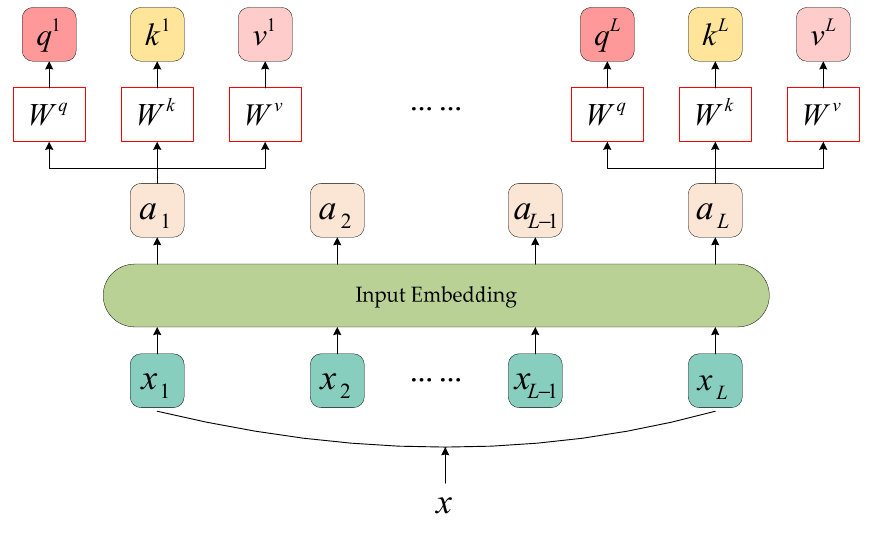
Figure 4. Generation mechanism of q, k, v.